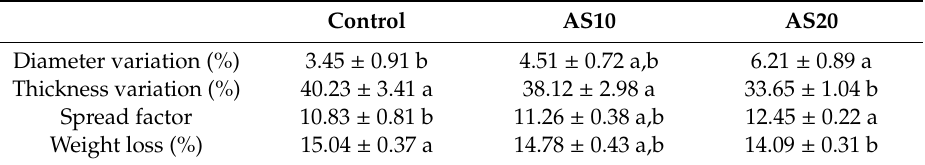
Di ff erent letters in row indicate significant di ff erences ( p <